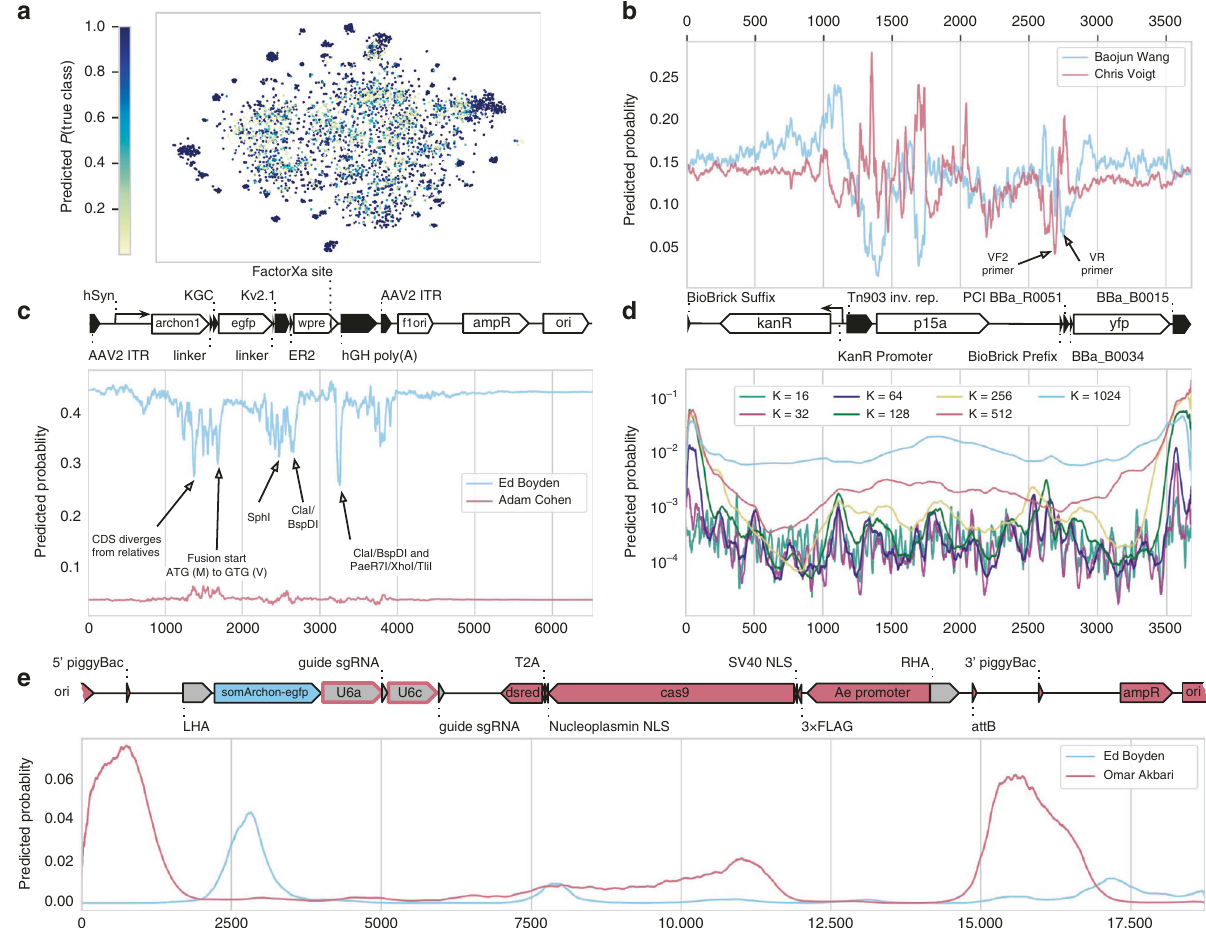
Fig. 5 Interpreting the deteRNNt model. a Two-dimensional tSNE of the pre-logit hidden layer of deteRNNt for the validation set. Colored by probability assigned to the true lab. An interactive 3d visualization is available at http://papers.altlabs.tech/visualize-hiddens.html. b Scanning mask of 10 N ’ s across linear sequence ( x axis) of Chris Voigt lab plasmid pCI-YFP, (Genbank JQ394803.1) on the brink of predicting Baojun Wang Lab vs. Voigt Lab. At each x position is shown the probabilities given by softmax on the mean of the logits from all the sequences which include that position masked with N. Plasmid schematic is shown below. c The scanning 10-N mask analysis from ( b ) applied to Edward Boyden Lab Plasmid pAAV-Syn-SomArchon (Addgene #126941). The second-most likely lab predicted by deteRNNt on this plasmid is shown in red, with plasmid schematic above. d Predicting lab-of-origin from subsequences of varying lengths K scanned across the linear sequence. At each x , the probabilities are given by softmax of the mean of logits from subsequences which include that position in the window. Color indicates subsequence K -mer length. Linear sequence position is given by the x axis and shared with ( b ) with the plasmid schematic above. e Custom-designed gene-drive plasmid derived from an Omar Akbari Aedes aegypti germline-Cas9 gene-drive backbone (AAEL010097-Cas9, Addgene #100707) carrying a payload of Cas9-dsRed, a guide cassette, and SomArchon from the Boyden plasmid pAAV-Syn-SomArchon from ( c ), with scanning subsequence window as in ( d ) and K = 1024. Predicted probabilities for Omar Akbari (red) and Boyden (blue) are shown, along with the correspondingly colored plasmid schematic. All unlabeled regions are from the Akbari vector. The right and left homology arms shown in gray were introduced by our design and come from neither lab ’ s material, and the U6a and U6c were from Akbari lab material (Addgene #117221 and #117223, respectively) but introduced into the backbone by our design (gray outlined in